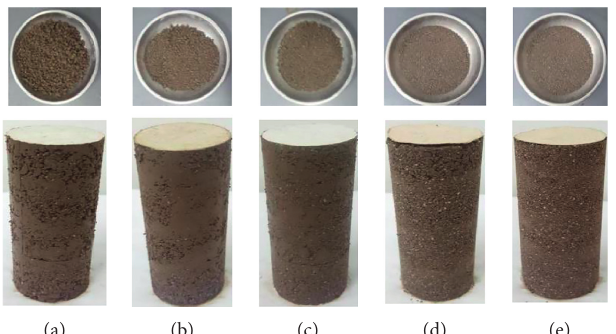
Figure 2: The triaxial mixture sample of different steel slag. (a) α